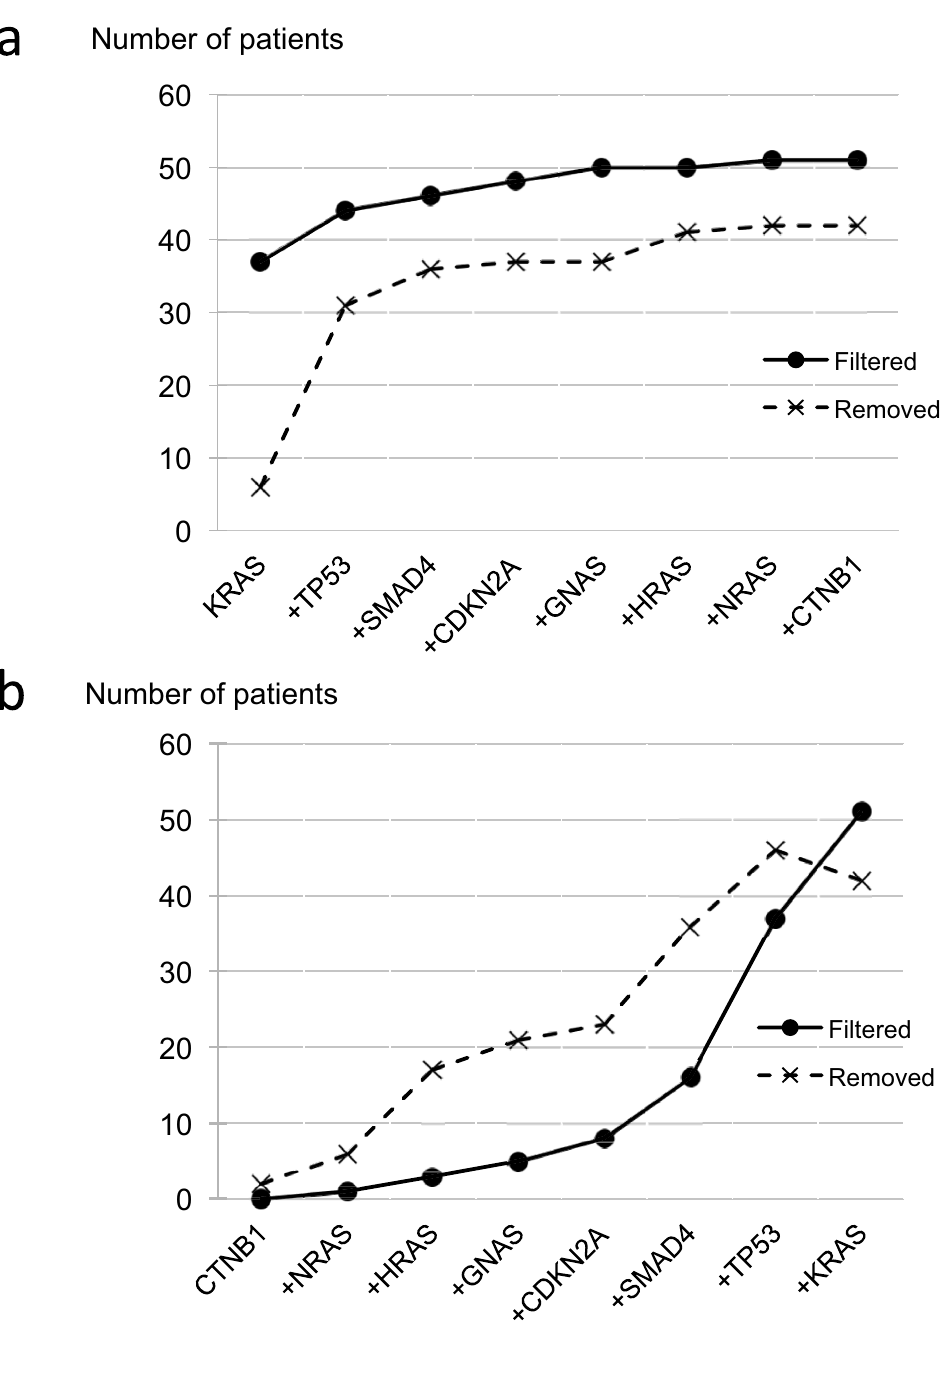
Fig 2. Cumulative numbers of variant-positive patients obtained by addition of genes. A, Genes are in descending order according to the number of variants. B, Genes are in ascending order according to the number of variants. The y-axis shows the number of patients, and the x-axis shows genes in order of the number of variant-positive patients identified. Solid line: patients identified by filtered variants; broken line: patients removed by CV78